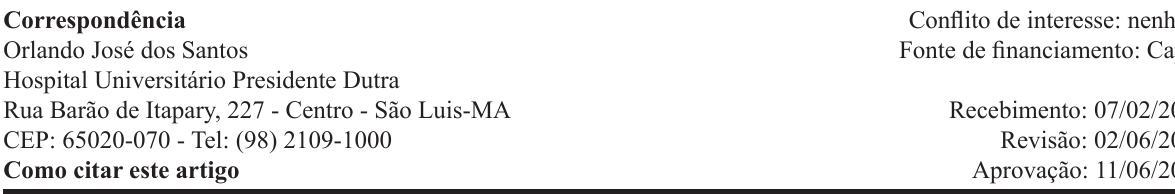
Figuras coloridas disponíveis em